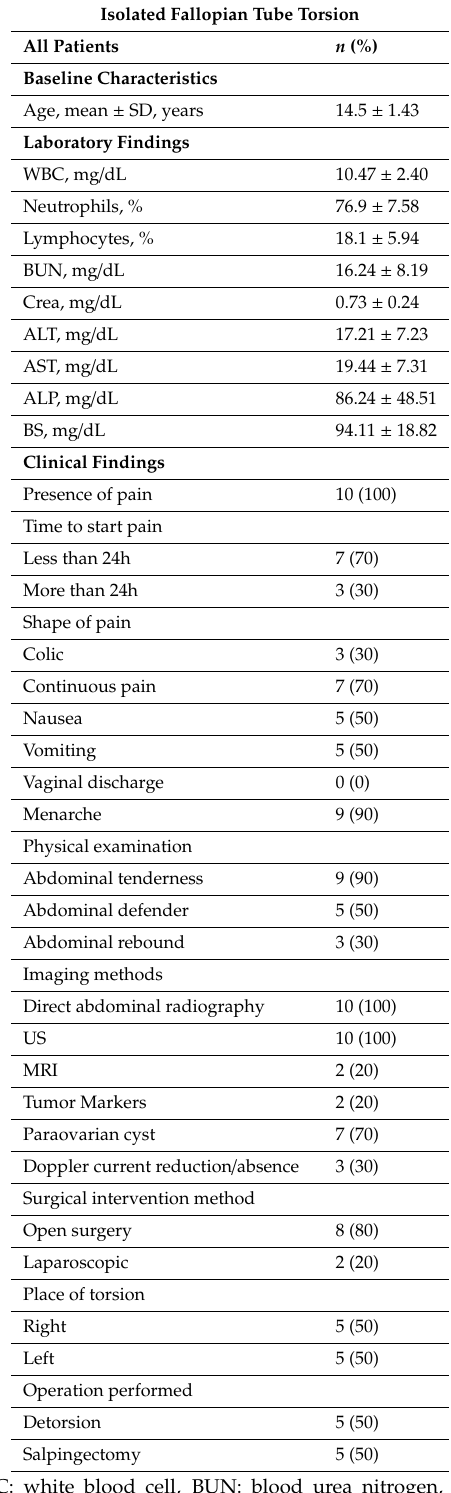
Table 1. Baseline characteristics, laboratory, and clinical finding of study